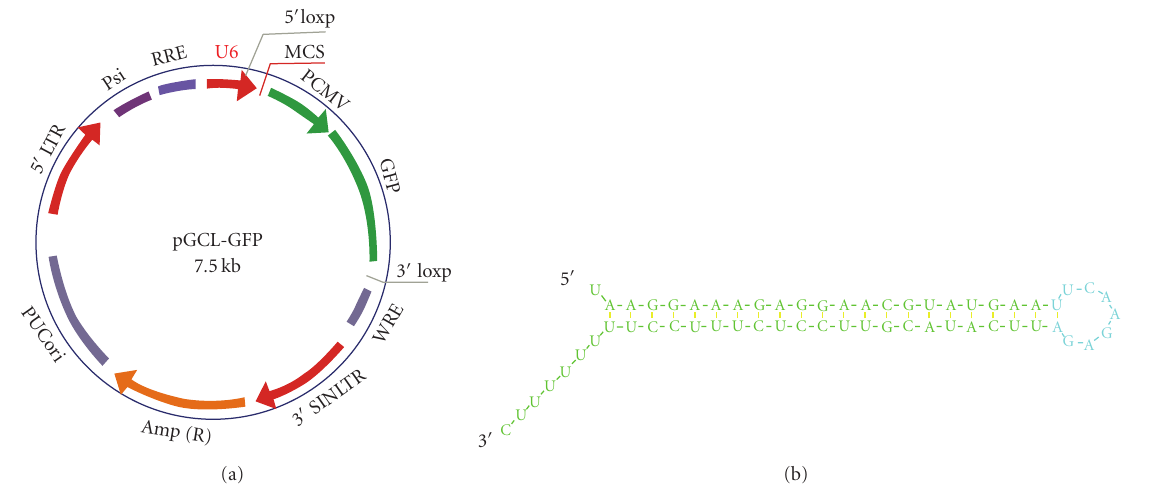
Figure 1: (a) Schematic presentation of the plasmid pGCL-GFP, which encodes an HIV-derived lentiviral vector containing a multiple cloning site (MCS) for insertion of shRNA constructs to be driven by an upstream U6 promoter and a downstream cytomegalovirus promoter-GFP fluorescent protein (marker gene) cassette flanked by loxp sites. (b) The stem-loop-encoded shRNA has sequence identity to a 21-nt region of CD80